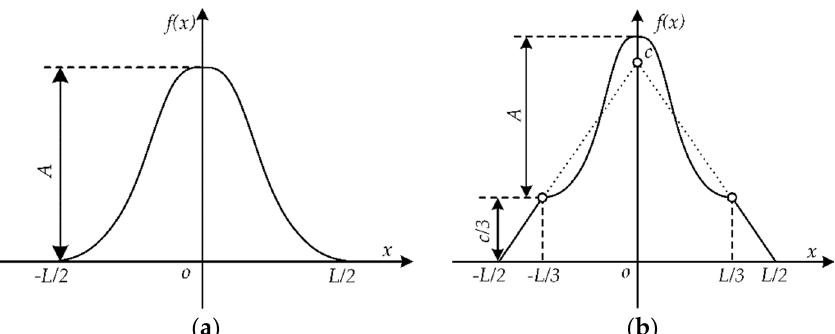
Figure 15. Acceleration response distribution model: ( a ) resonance; ( b ) nonresonance.